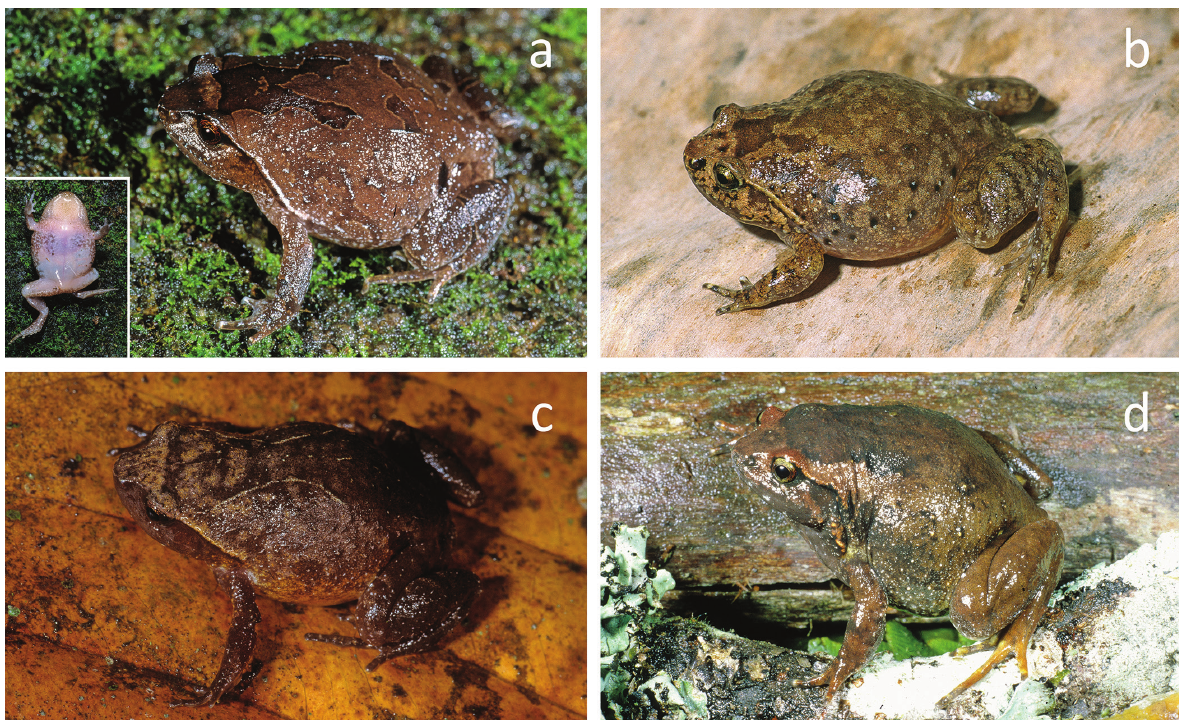
Figure 4. Individuals of ( a ) Plethodontohyla alluaudi in dorsolateral and (inset) ventral view (ZSM 89/2004 , until now referred to as P. bipunctata ; from Andohahela); ( b ) P. sp. Ca01 in dorsolateral view (ZCMV 555; from Ambatolahy); ( c ) P. brevipes in dor- solateral view (ZSM 649/2003; from Ranomafana); and ( d ) Rhombophryne sp. (formerly identified as R. alluaudi ) in lateral